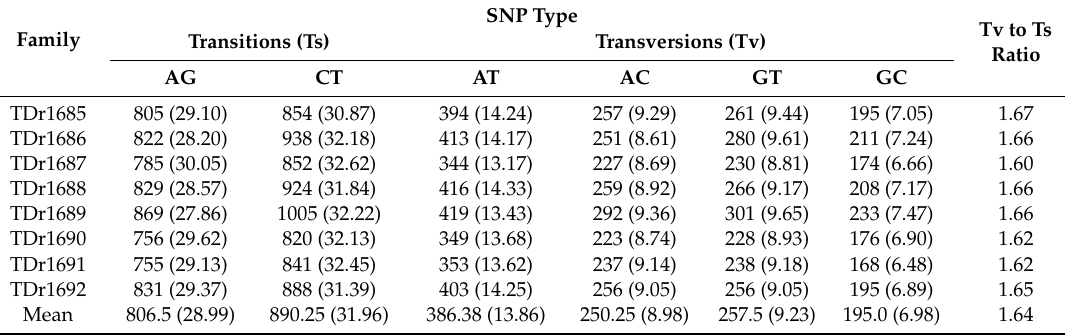
Table 4. Percentage of transition and transversion SNPs across the Dioscorea rotundata